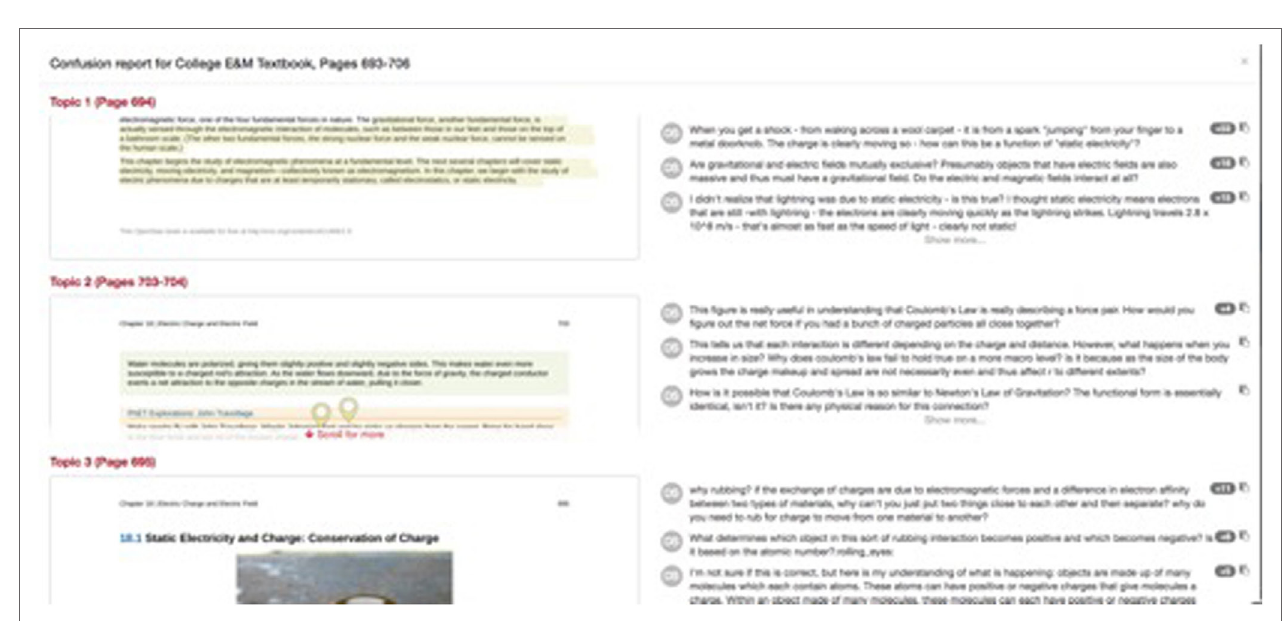
FigUre 8 | Confusion report in Perusall